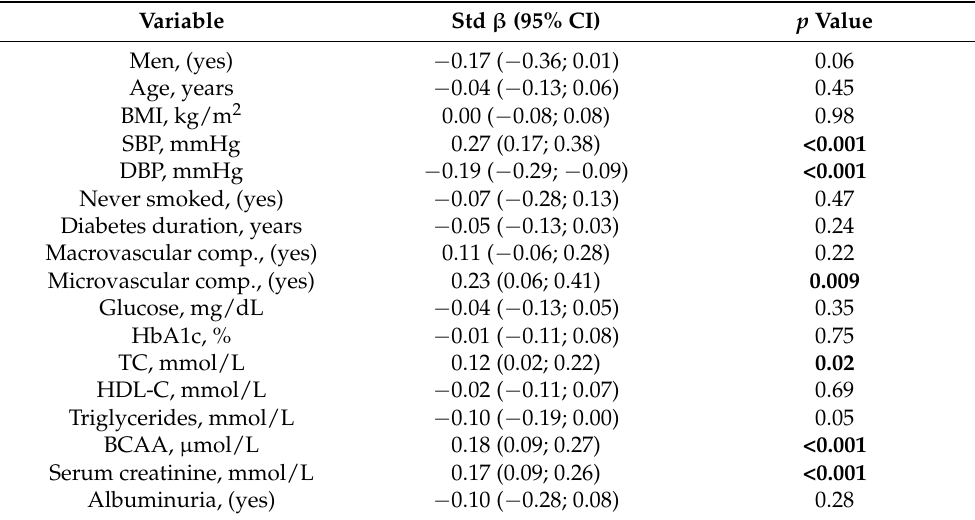
Table 2. Multivariable associations of baseline characteristics with plasma concentrations of